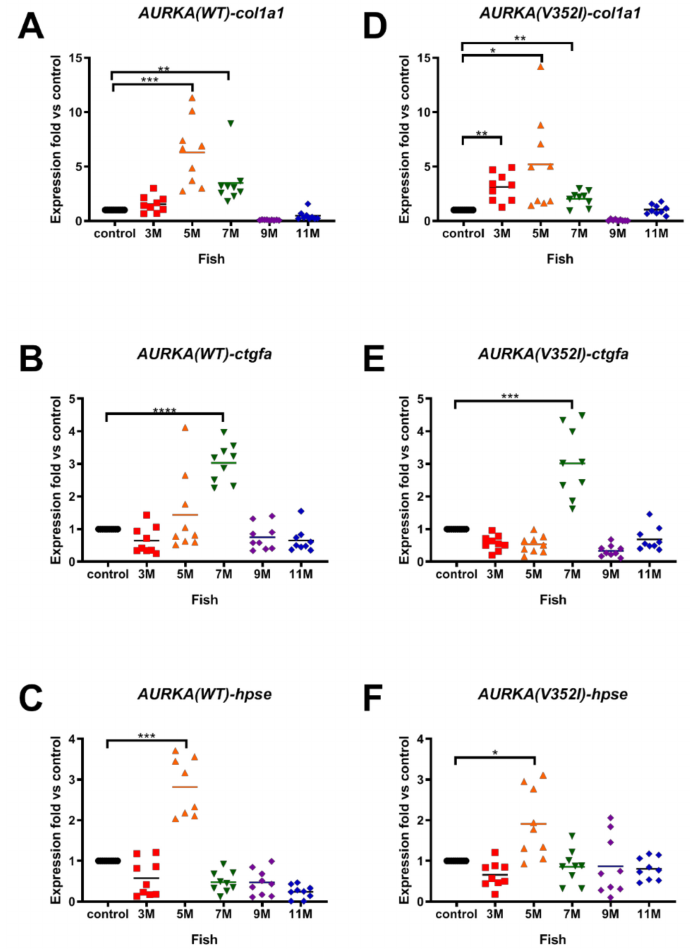
Figure 4. Expression of fibrosis markers (collagen type I alpha 1 ( col1a1 ), connective tissue growth factor ( ctgfa ), heparanase ( hpse )) in AURKA(WT) and AURKA(V352I) transgenic fish compared to control. qPCR analysis of fibrosis markers ( A , D ) col1a1 ; ( B , E ) ctgfa ; ( C , F ) hpse in AURKA(WT) ( A – C ) and AURKA(V352I) ( D – F ) transgenic zebrafish compared to control fish at di ff erent time points. Expression fold compared to control fish (Tg(fabp10a:EGFP-mCherry) is shown in red (3 M), orange (5 M), green (7 M), purple (9 M), and blue (11 M). Statistical analysis of results was performed using a two-tailed Student’s t -test. Asterisks (*) represent the level of significance. * p -value ≤ 0.05; ** p -value ≤ 0.01; *** p -value ≤ 0.001; **** p -value ≤